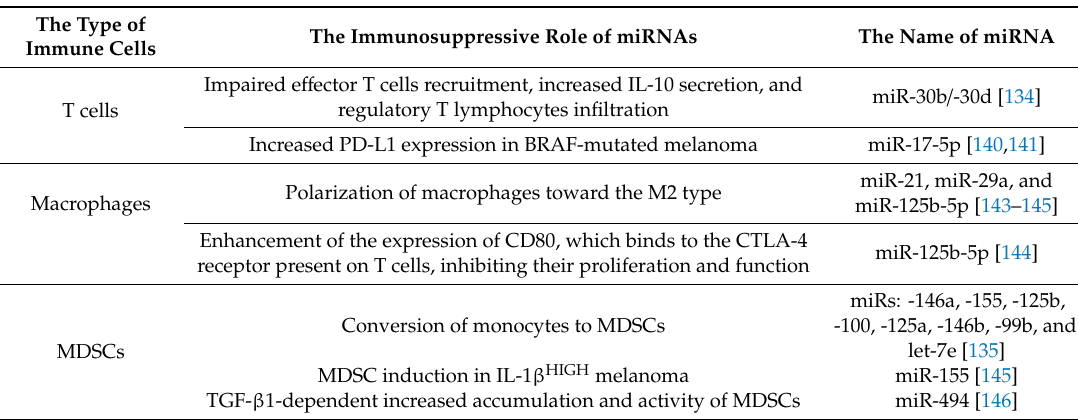
Table 6. Immunosuppressive and immunogenic roles of miRNAs in the melanoma microenvironment. The Type of Immune